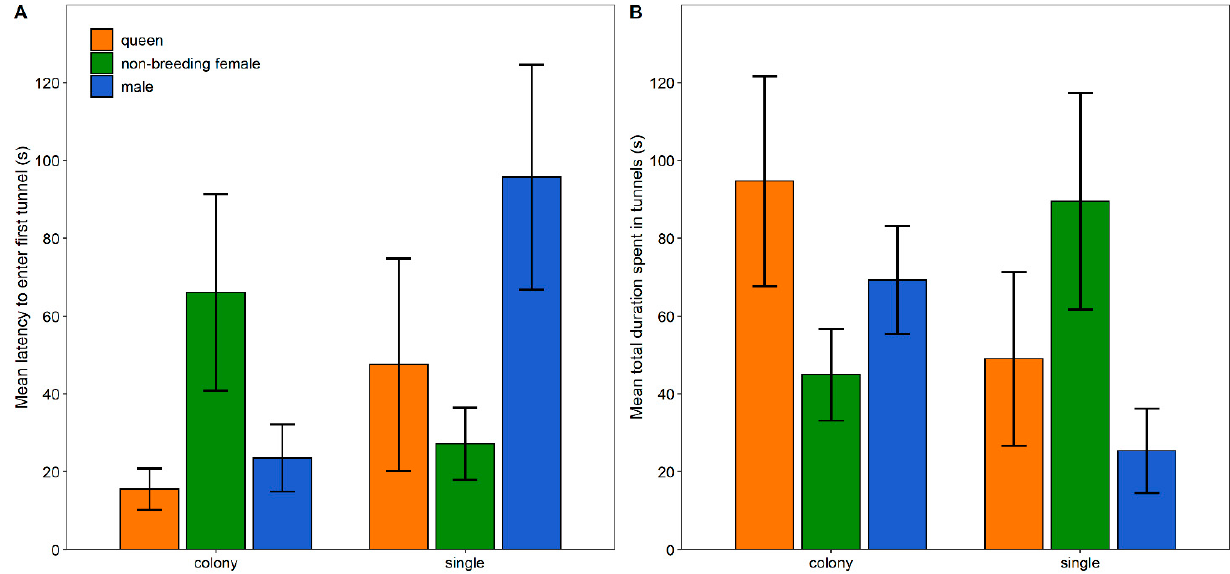
Figure 1. Latency to enter the first tunnel (±SE) ( A ) and total duration spent in tunnels (±SE) ( B ) by colony- and single-housed Damaraland mole-rats in an open-field box.